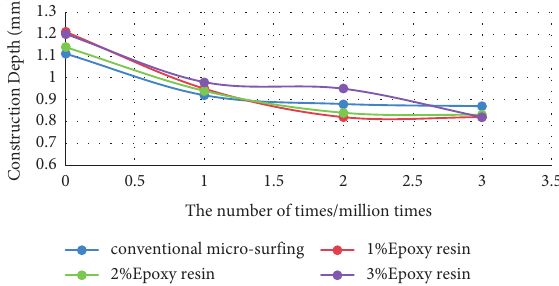
Figure 4: Curve of texture depth of epoxy high-performance microsurfacing.